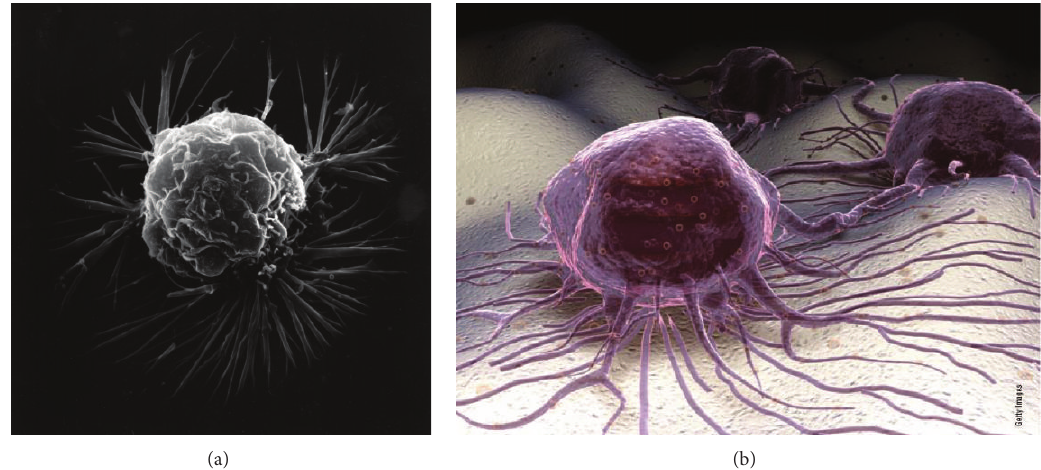
Figure 9: (a) SEM of a breast cancer cell that clearly shows both the soft petals of membrane ruffling and much longer lamellipodia spiking extensions. (b) A scanning electron microscopic 3D-enhanced NIH image of cancer cells and lamellipodia spike processes on a cellular tissue surface (with permission from the National Institutes of Health/Department of Health and Human